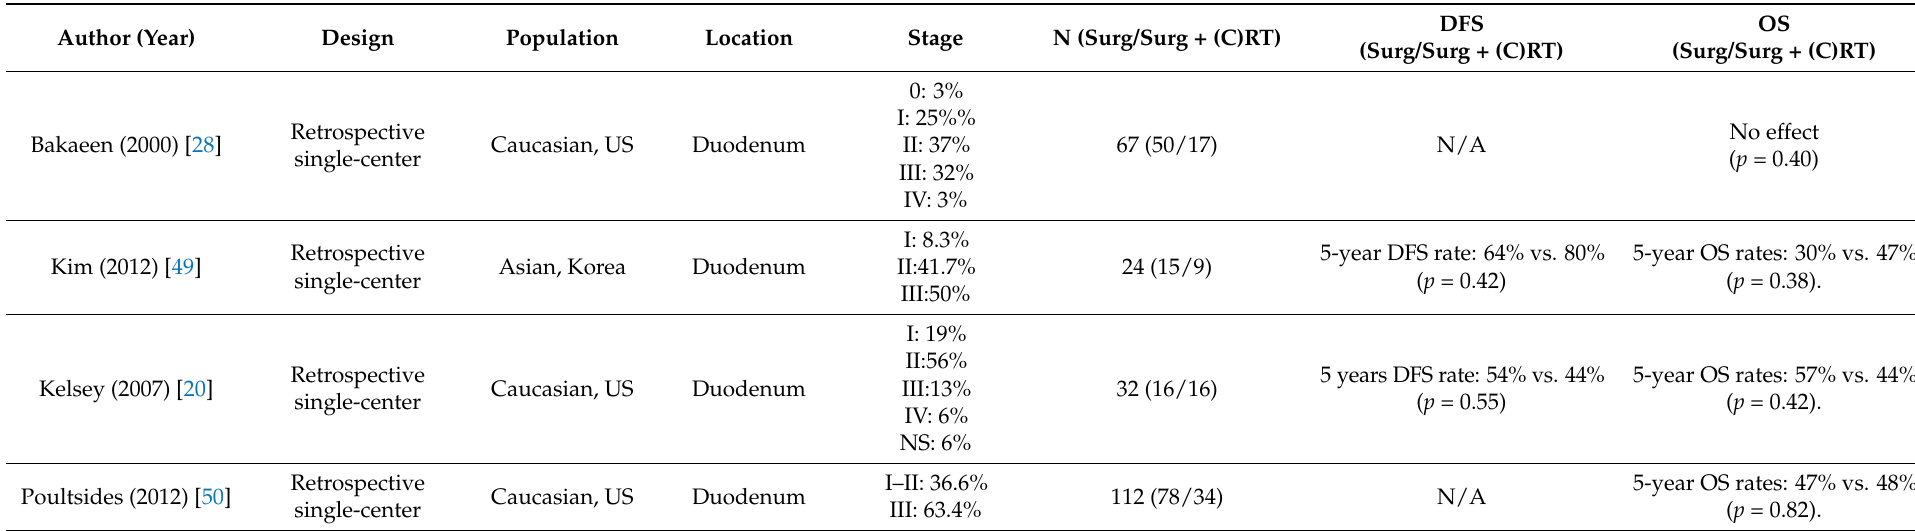
Table 2. Efficacy of adjuvant radio+/-chemotherapy versus surgery alone on disease-free survival and overall survival in small bowel